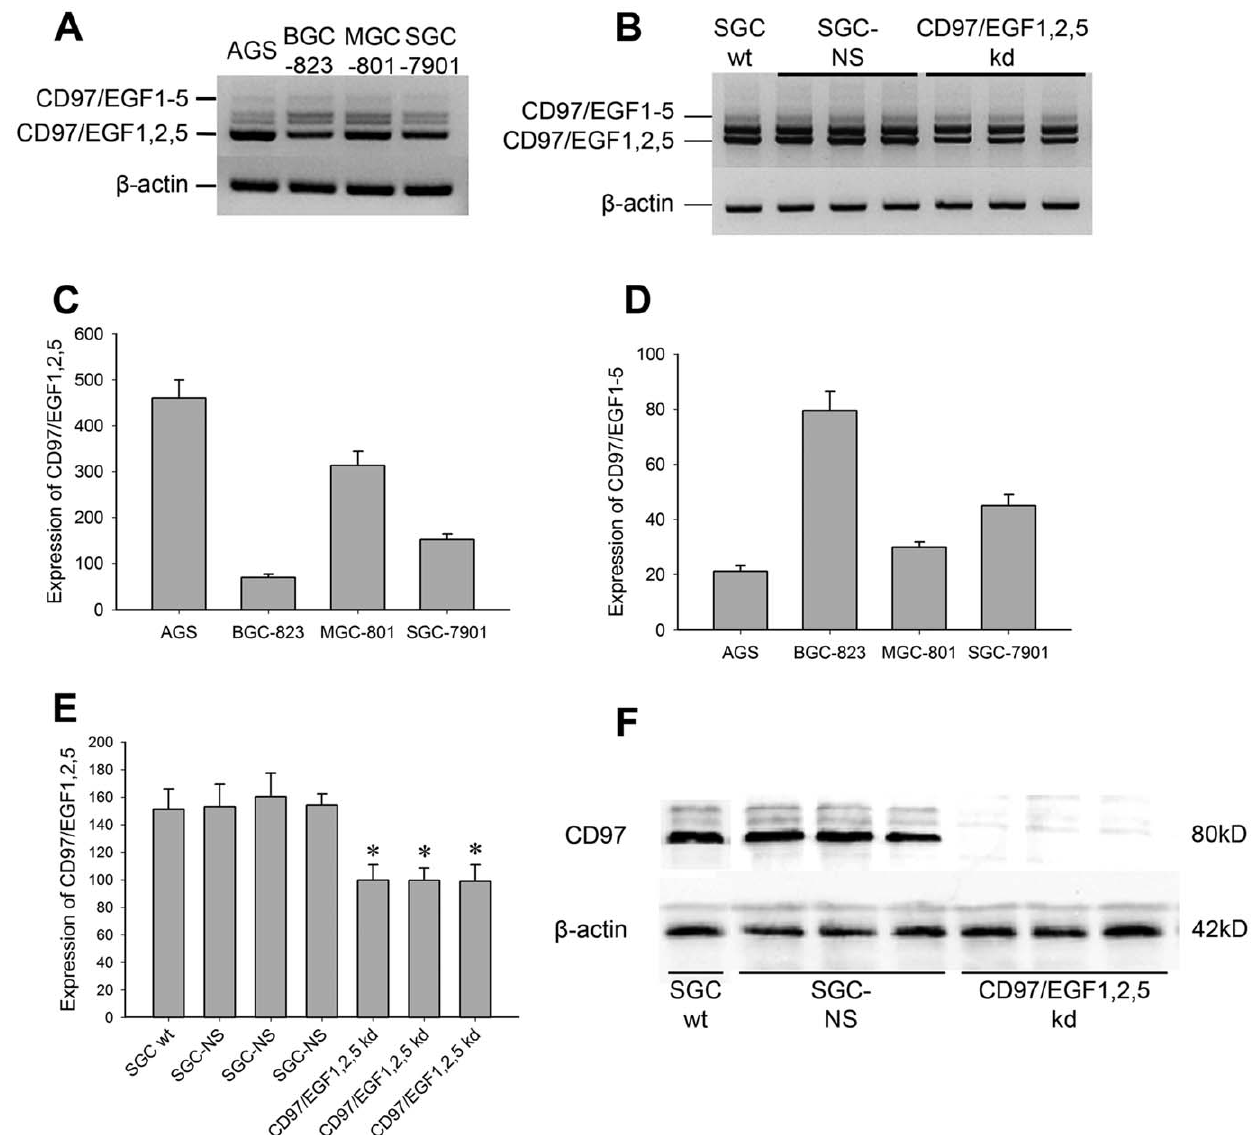
Figure 1. Generation of transfectants with stable knockdown of CD97 small isoform. (A) CD97 expression on gastric carcinoma cell lines SGC-7901, AGS, BGC-823 and MGC-801. (B) Expression of CD97 isoforms in SGCwt, SGC-NS and CD97/EGF1,2,5 knockdown groups. Semi-quantitative RT-PCR analysis, performed with the Bio 1D software, revealed differentially expressed (C) CD97 small and (D) big isoforms of the four cell lines, and significantly decreased levels of (E) CD97 small isoforms in CD97/EGF1,2,5 knockdown group as compared with corresponding controls (*p , 0.01). (F) The , 85 kDa CD97 protein was detected by Western blot analysis in total cellular extracts of SGCwt cells, SGC-NS and CD97/EGF1,2,5 knockdown